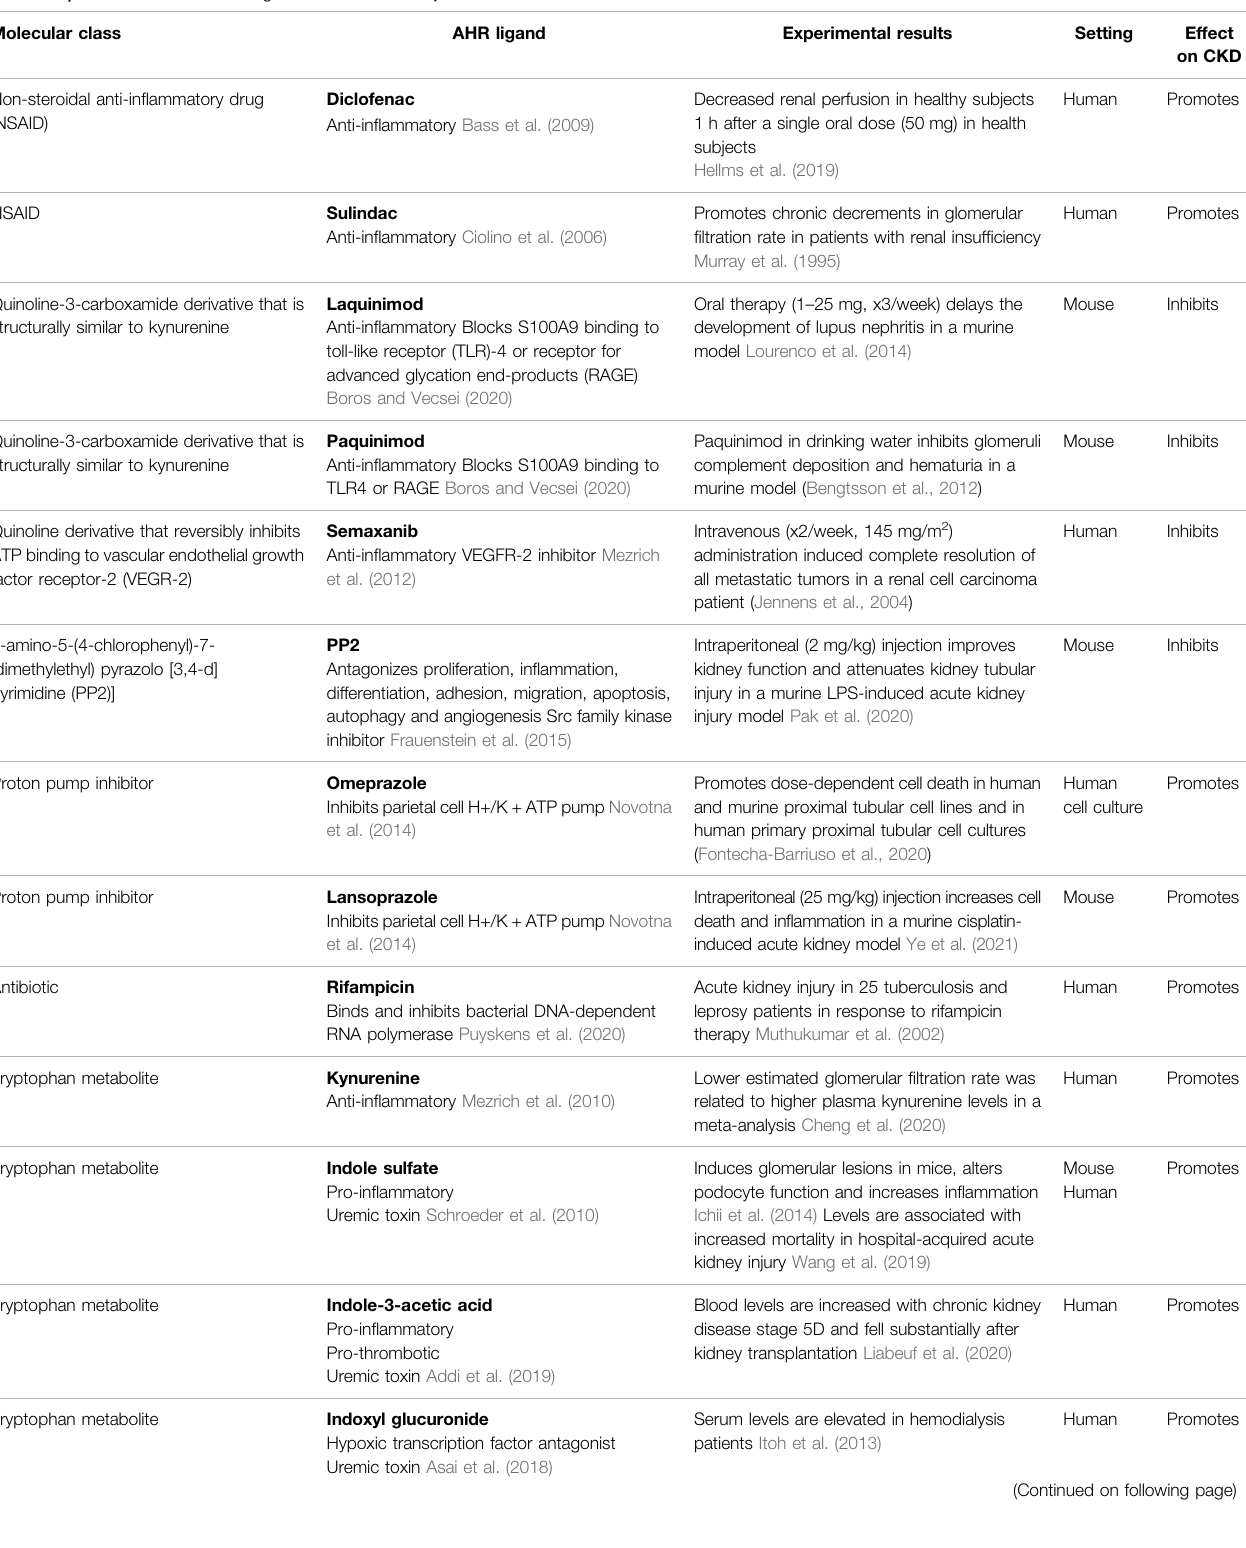
TABLE 1 | Function of select AHR ligands in chronic kidney